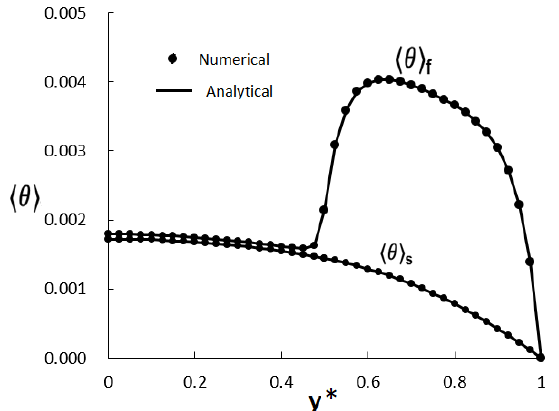
Figure 4. Comparison between the analytical and numerical results for LHC when 𝜁 = 0.5 and 𝑅𝑒 𝐻 =10.